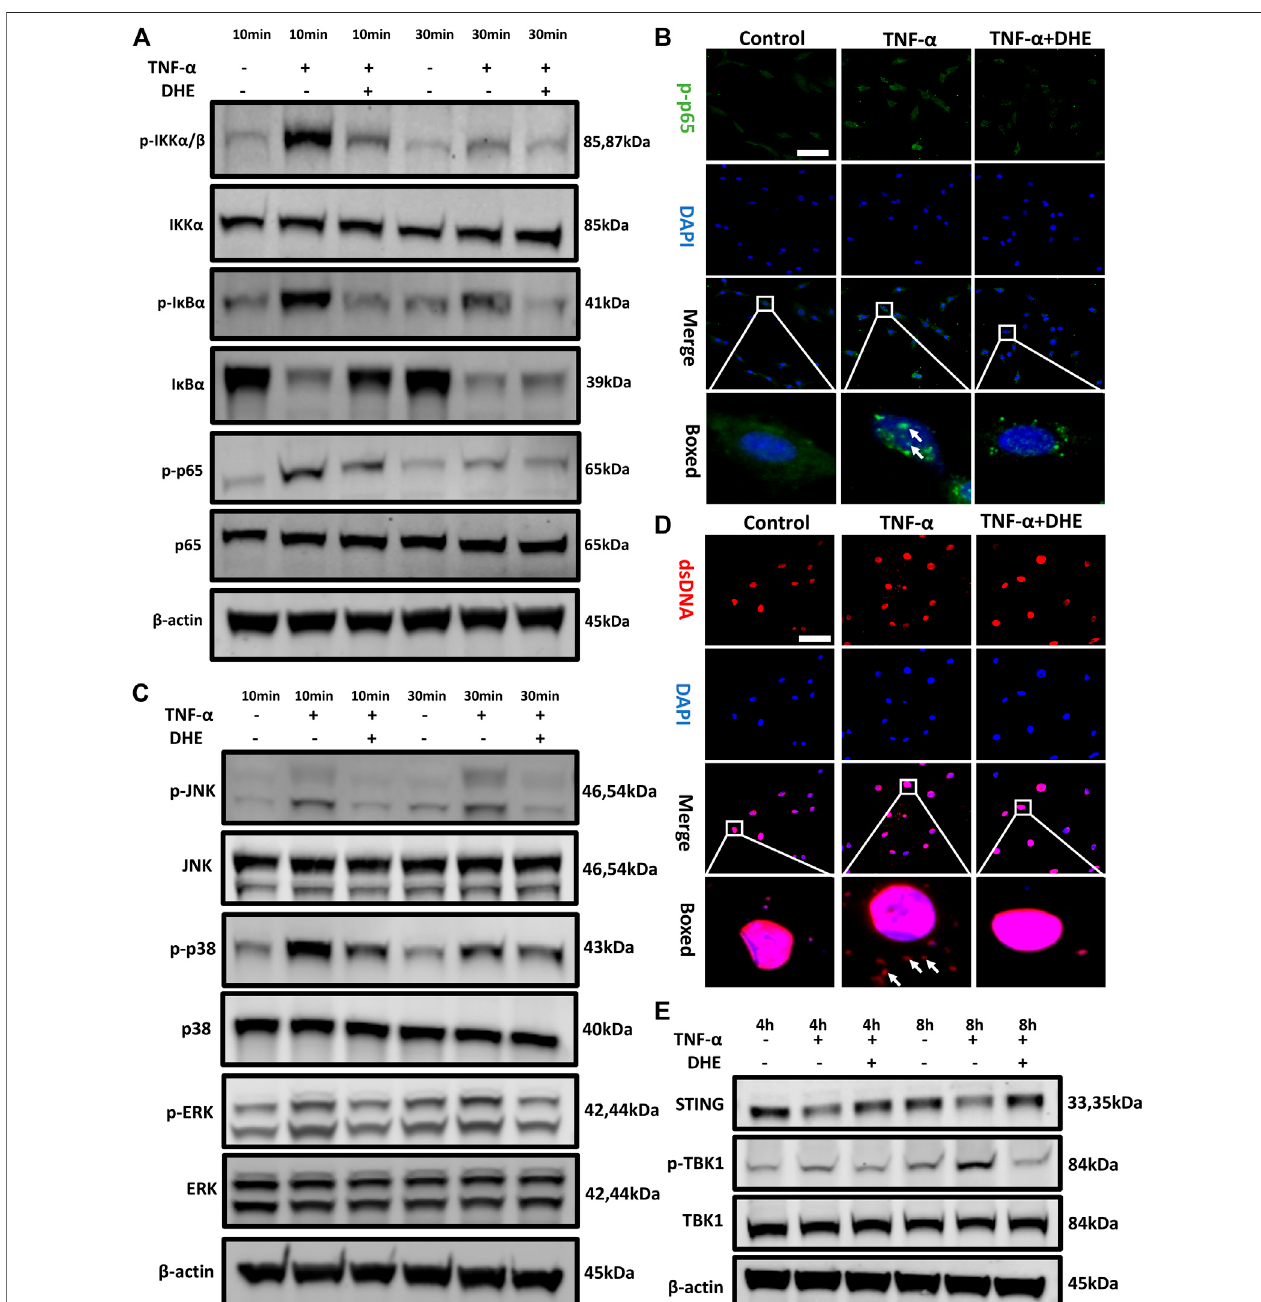
FIGURE 3 | Effects of dehydrocostus lactone (DHE) on tumor necrosis factor- α (TNF- α ) – induced NF- κ B and MAPK as well as dsDNA release – induced STING- TBK1 activation in nucleus pulposus (NP) cells (A) Immunoblotting showed the DHE alleviation effects on the phosphorylation of IKK α , I κ B α , and p65 and on the degeneration of total I κ B α induced by TNF- α . All NP cells were pretreated with DHE (2.5 μ M) for 2 h and then stimulated with TNF- α for 10 or 30 min (B) The phosphorylation of NF- κ B p65 and nuclear translocation were detected by immuno fl uorescence. The arrows indicate the entry of phosphorylated p65 into the nucleus. Scale bar, 10 μ m (C) Western blot showed the DHE alleviation effects on the phosphorylation of p38, JNK, and ERK induced by TNF- α . All NP cells were pretreated with DHE (2.5 μ M) for 2 h and then stimulated with TNF- α for 10 or 30 min (D) The dsDNA in the cytoplasm was detected by immuno fl uorescence after the treatmentofTNF- α (20 ng/ml)withor withoutDHE(2.5 μ M) for8 h. Thearrows showanincrease indsDNA inthecytoplasm.Scalebar,10 μ m (E) Western blotshowed the alleviation effects of DHE on the phosphorylation of TBK1 induced by dsDNA release and caused by TNF- α . All NP cells were treated with TNF- α (20 ng/ml) with or without DHE (2.5 μ M) for 4 h or 8